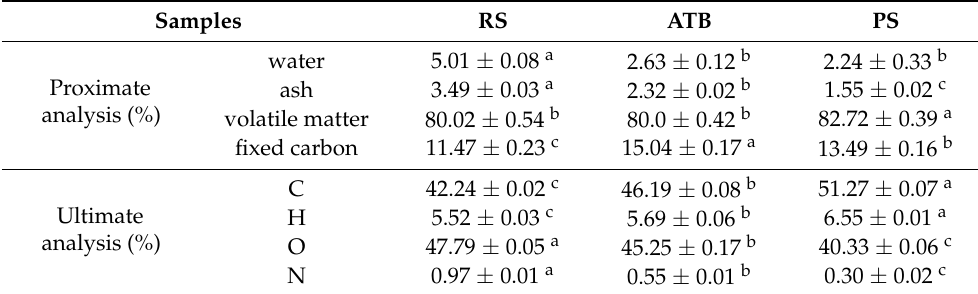
Table 2. Proximate analysis and ultimate analysis of samples.